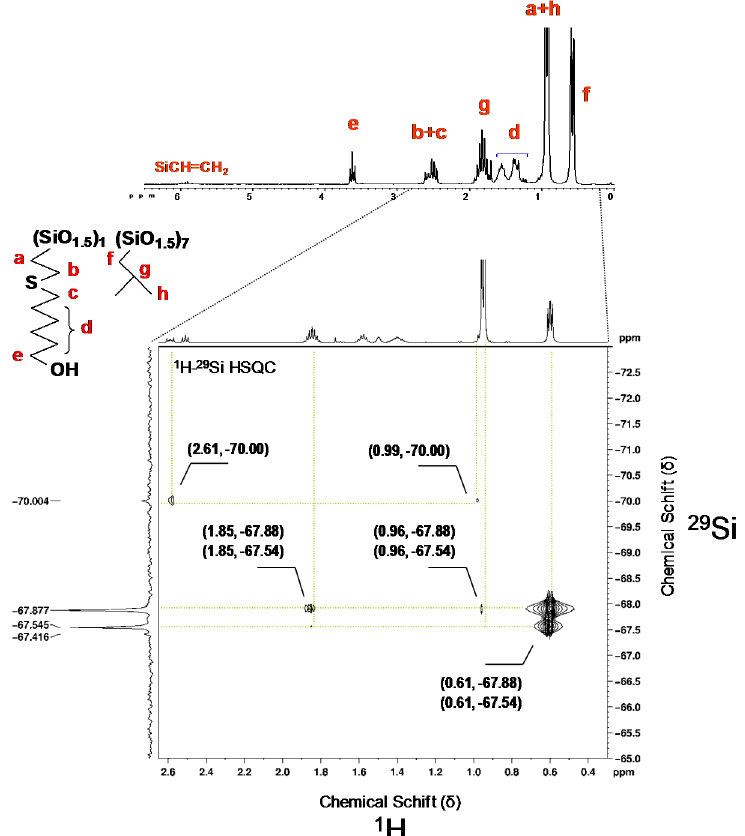
Figure 2. 1 H– 29 Si HSQC(CDCl 3 ) spectrum of (iBu-POSS-S-OH)(4) obtained by thiol-ene addition of 6-mercaptohexanol-1 to heptaisobutylvinyloctasilsesquioxane (conversion of vinyl groups